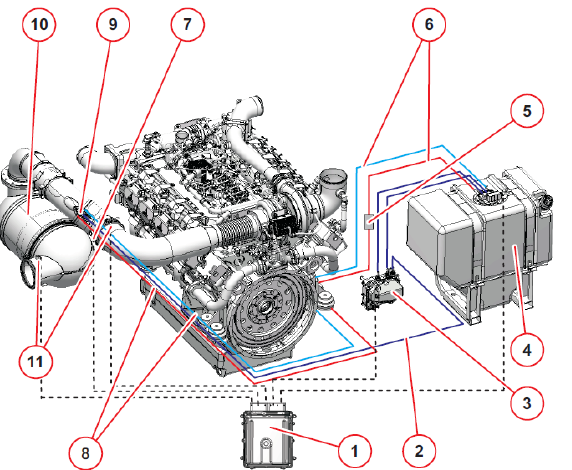
Figure 3. The diesel engine DEUTZ TCD 12.0 V6 installed on the LHD-1701 vehicle and its SCR